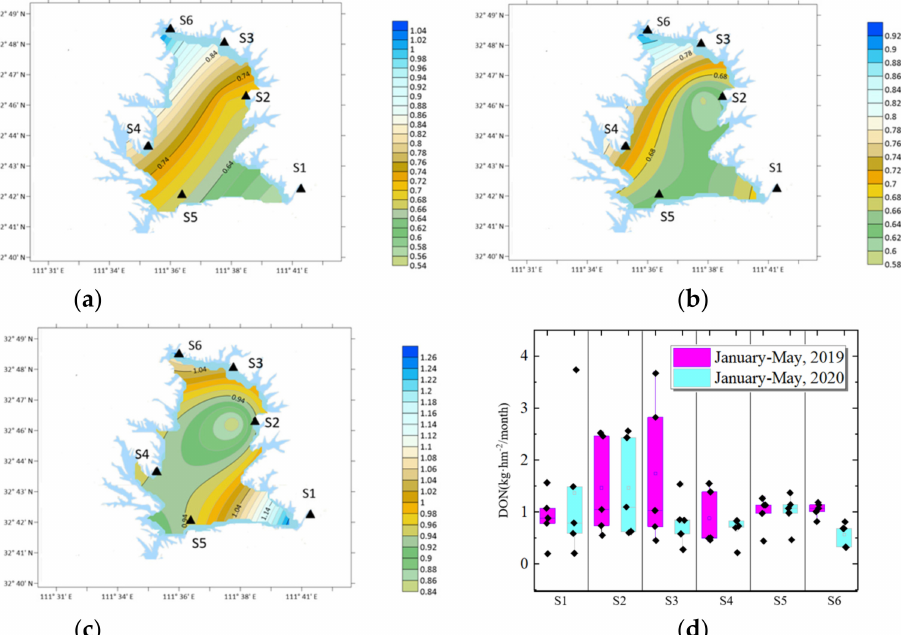
Figure 9. DON distribution around COVID-19 lockdown. ( a ) Before lockdown; ( b ) middle lockdown; ( c ) after lockdown; ( d ) DON compared with